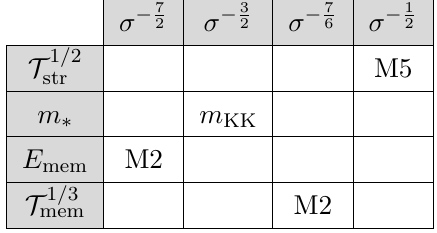
Table 15 . Mass scalings along the flows generated by the string with charges (1 , 1 , 0 , 1 , 0 , 0 , 0) . e = (1 , 1 , 0 , 1 , 0 , 0 , 0) Consider non-elementary strings with only non-null charges e 1 = e 2 = e 4 = 1 . Since s 1 ∼ s 2 ∼ s 4 ∼ σ → ∞ , the tower scale m KK scale (for R = R , R , R ). These scale ∗ 1 2 4